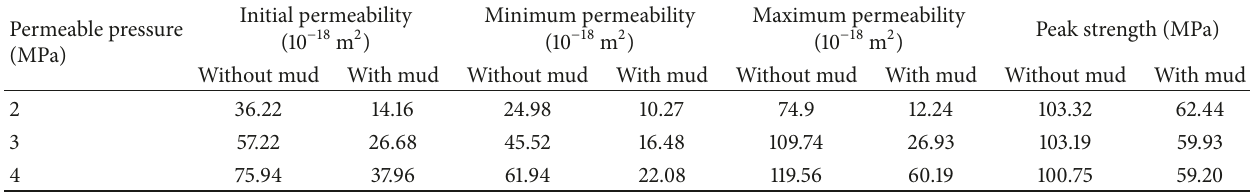
Table 5: Permeability and strength considering confining pressure 15 MPa and different water pressure. Permeable